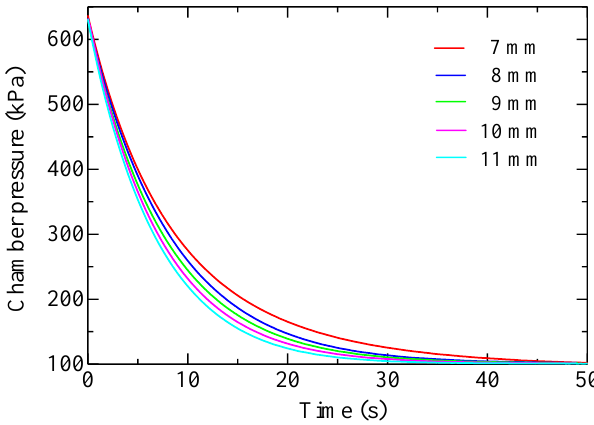
Figure 9. Pressure in the chamber versus time during discharge process for the five porous media of group 2.